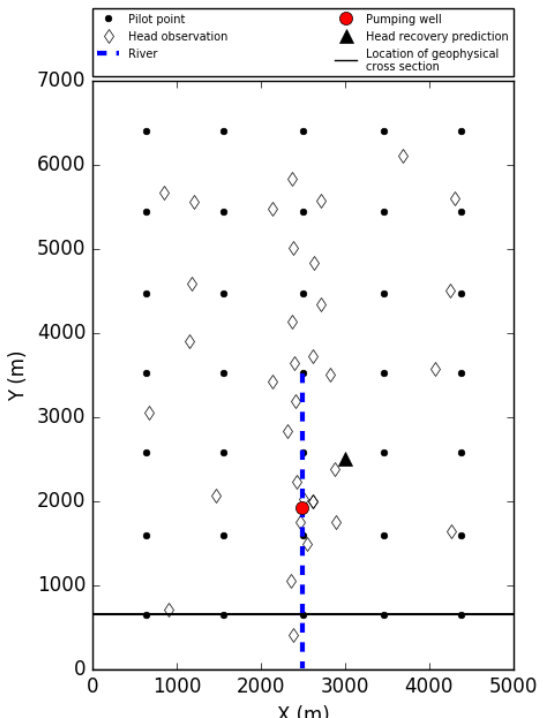
Figure 2. A map of locations of boreholes, a pumping well, pilot points, head recovery prediction, and location of a geophysical cross